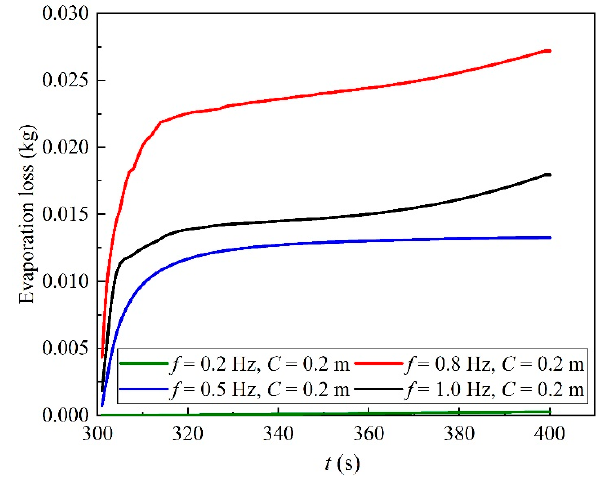
Figure 14. Dynamic evaporation loss under different sloshing frequencies.